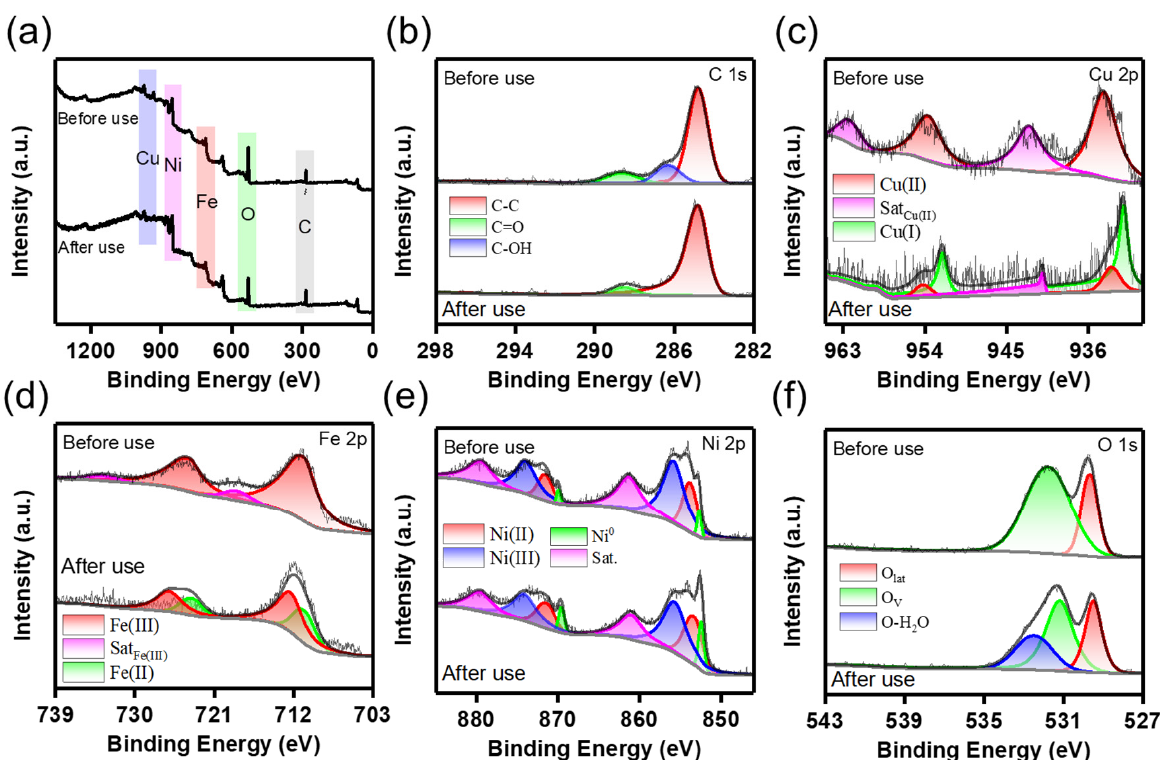
Figure 7. XPS spectra of fresh and used CFO-NF: ( a ) survey spectra, ( b ) C 1s, ( c ) Cu 2p, ( d ) Fe 2p, ( e ) Ni 2p, and ( f ) O 1s.